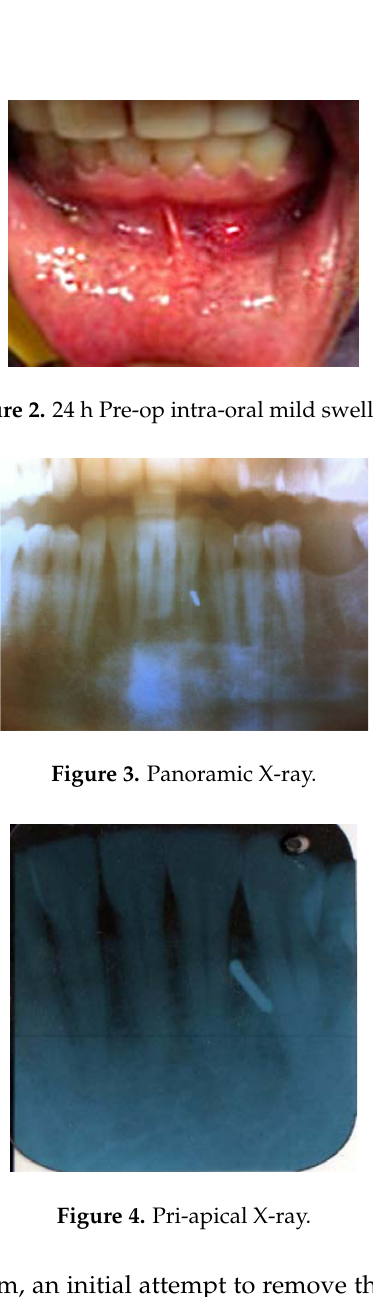
Figure 1. 24 h Pre-op extra-oral mild swelling.